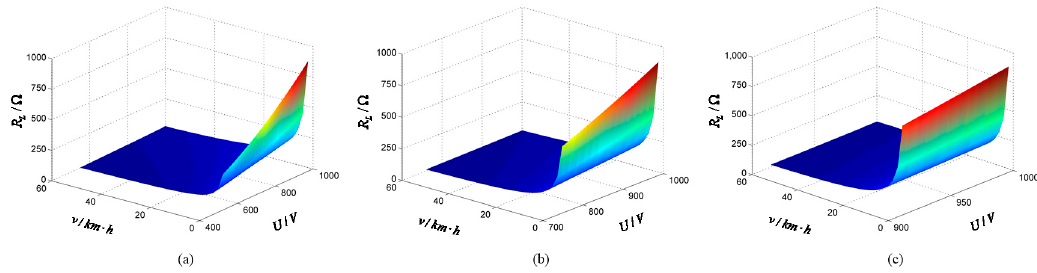
Figure 4. Diagram of R L 0 as a function of v and U : ( a ) n = 1; ( b ) n = 2; ( c ) n = 3.